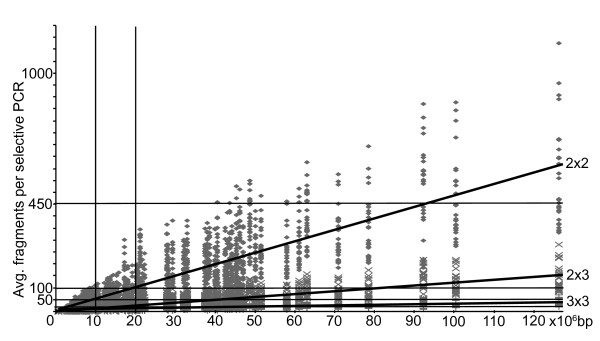
A positive relationship between cDNA pool size and the number of fragments per PCR. Linear regressions of average fragment numbers produced during in silico selective cDNA-AFLP PCRs against the absolute cDNA pool size in bp. Symbols indicate the average fragment numbers produced per enzyme combination and species for selective amplifications using 2 × 2 (diamonds), 2 × 3 (crosses) and 3 × 3 (pluses) selective base pairs, respectively. Duplicate species have been removed from this analysis. The numbers of selective base pairs used for each primer in the selective PCR are indicated, and regression lines have been added for each of the three amplification types. The correlation coefficient for each of the three datasets is 0.74. The production of fewer than 20 fragments per PCR minimizes the possibility of collisions [8], while up to 100 fragments per reaction are often desired when performing AFLP on genomic DNA [3]. A maximum of 450 fragments can be separated in the typical size range of AFLP screens (50-500 bp). Vertical reference lines indicate the total cDNA pool size range expected in a typical tissue expressing between 7500 and 15000 different cDNAs [24] assuming an average cDNA length of 1346 bp [12].